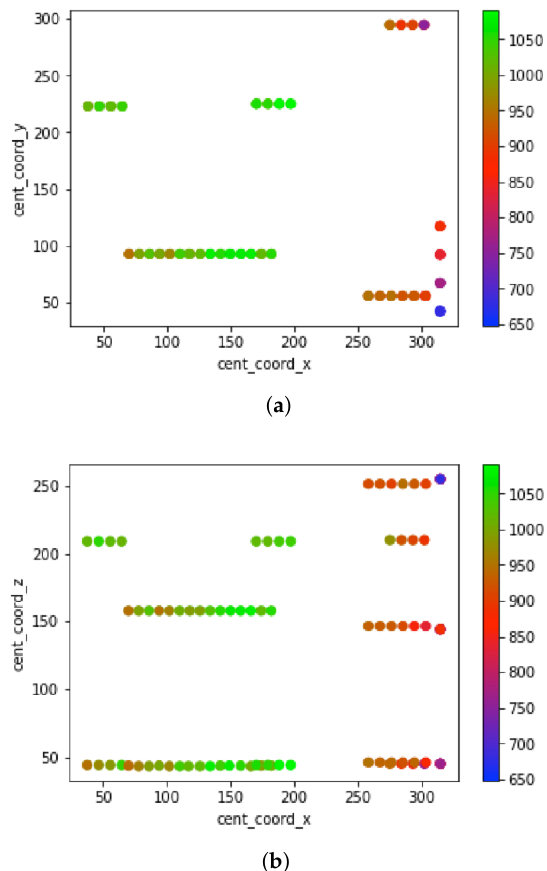
Figure 8. Visualization of Tensile Modulus for ZYX orientation ( a ) As a function of central coordinates in the X- and Y-axes in mm. ( b ) As a function of central coordinates in the X- and Z-axes in